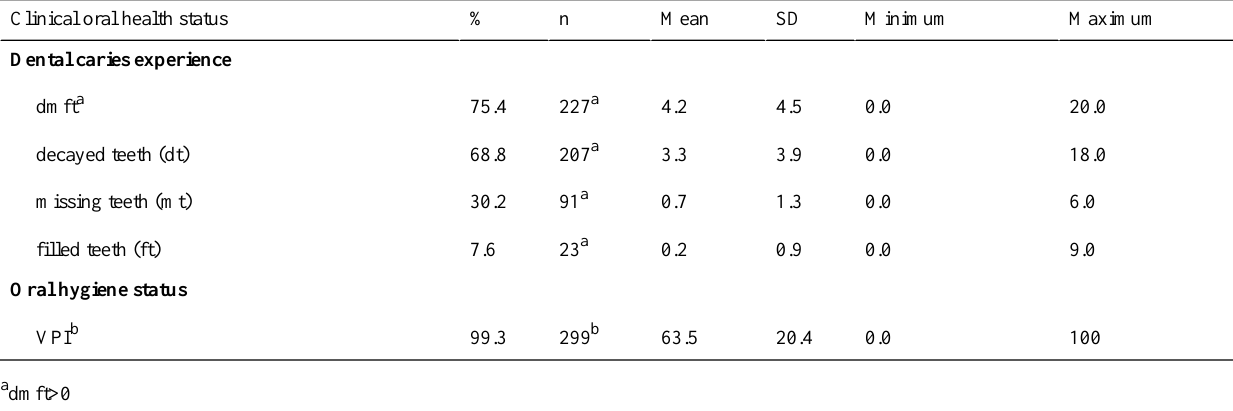
Table 4. Clinical oral health status of children: dental caries experience (dmft) and oral hygiene status (VPI) (n=301